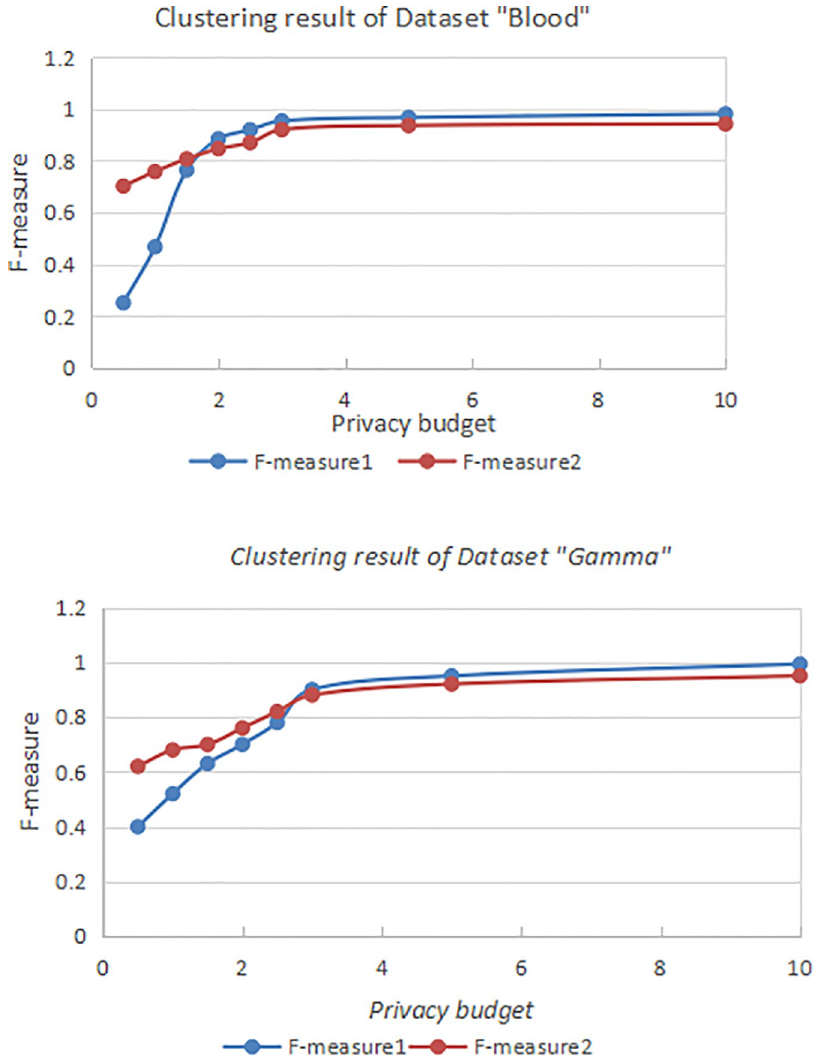
Fig 4. Availability measurement of datasets “Blood” and